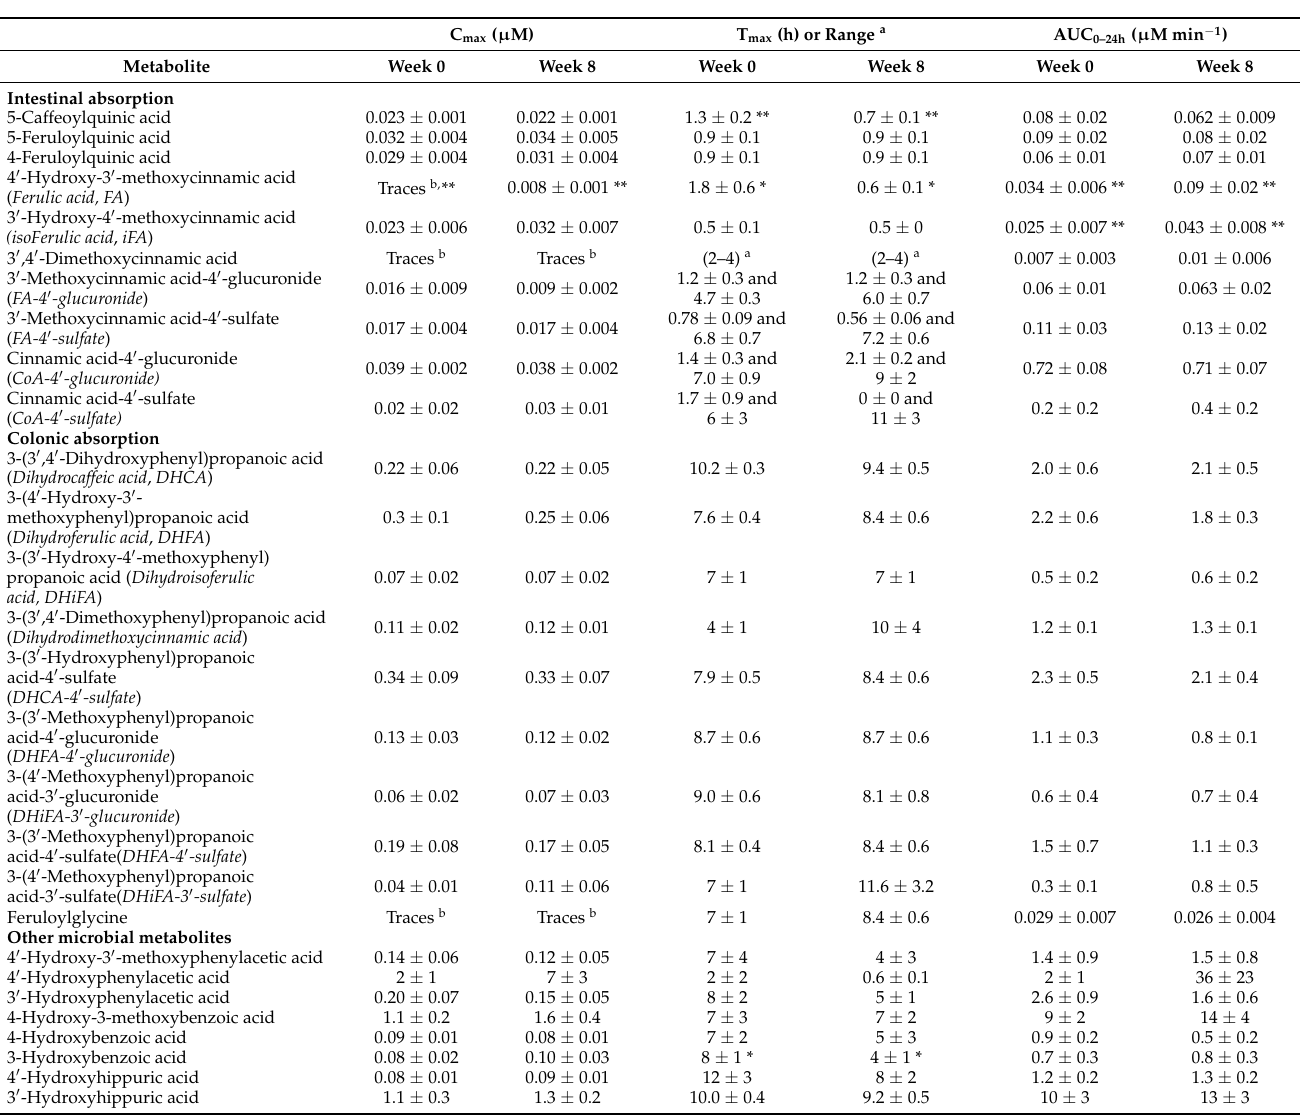
Table 1. Pharmacokinetics of plasma metabolites after consumption of the GCPE nutraceutical containing 300 mg of hydroxycinnamic acids at the beginning (week 0) and the end of the intervention (week